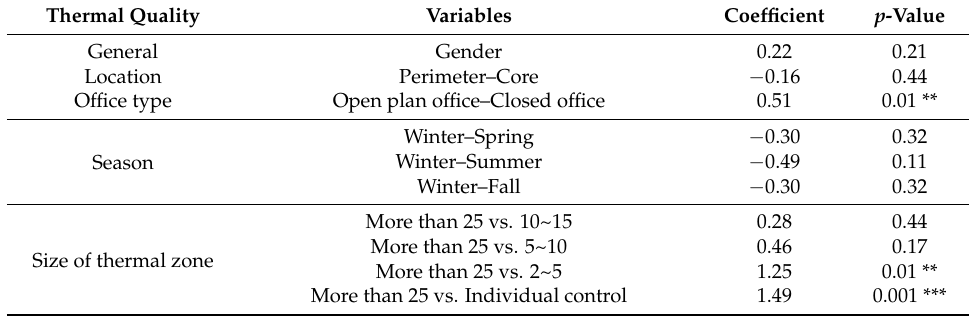
Table 6. Correlation of user satisfaction with a combination of technical attributes of building systems and workstation thermal quality measurements: Thermal